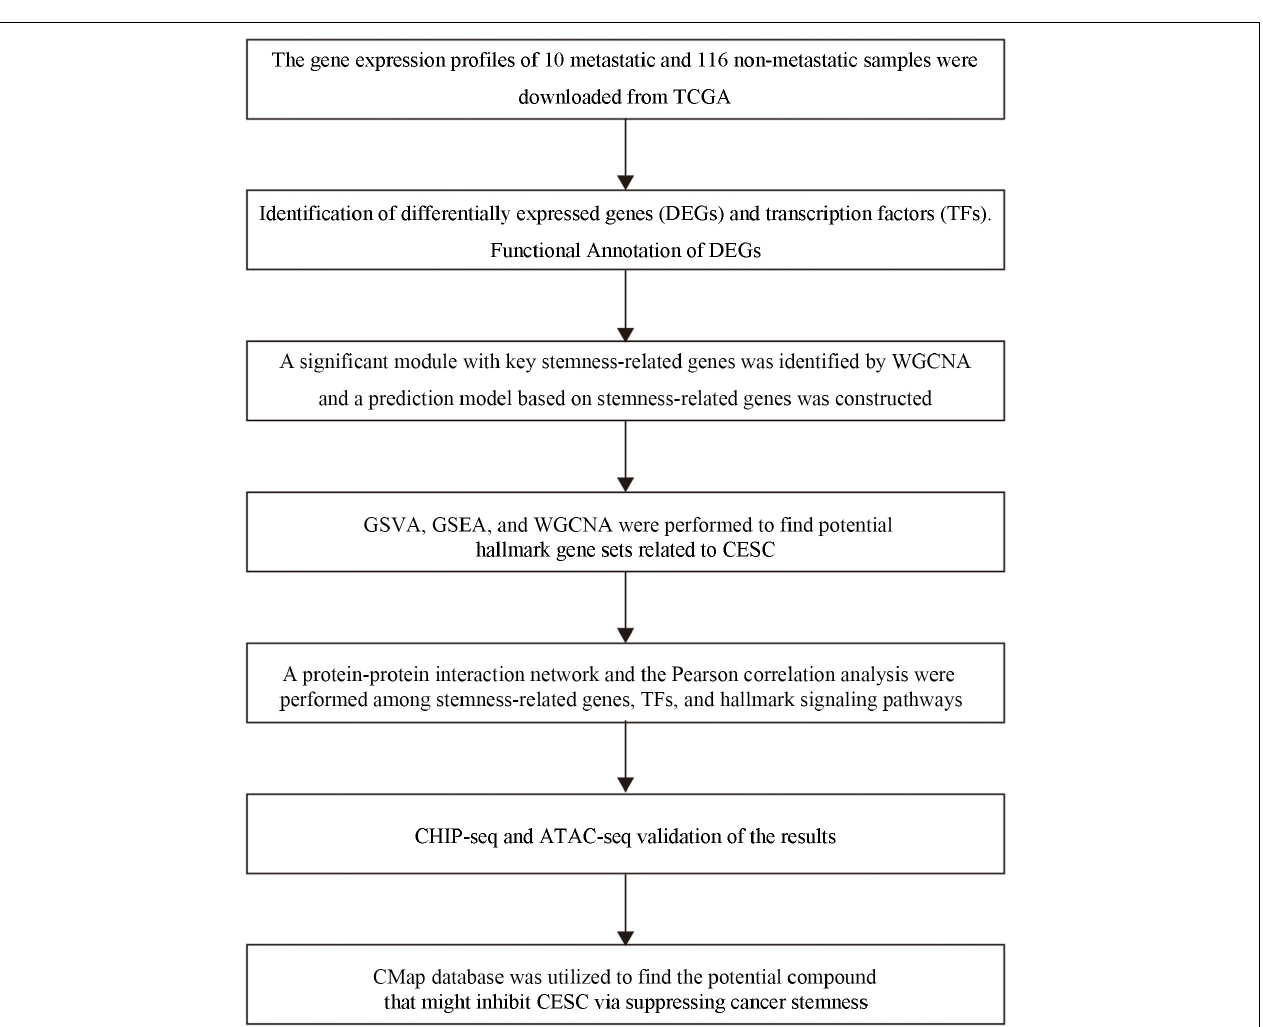
Figure 1 . Combinative analysis based on gene expression